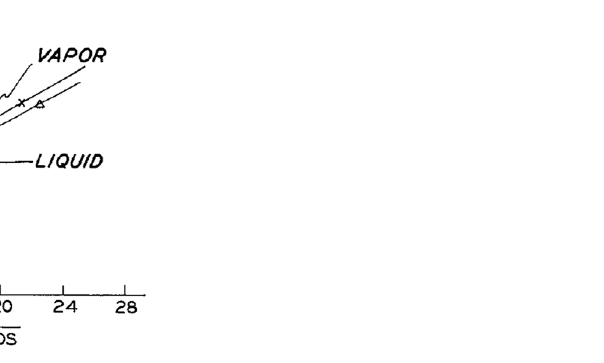
Figure 9. Position of temperature, humidity and water content fronts (from Perrier and Prakash) 9